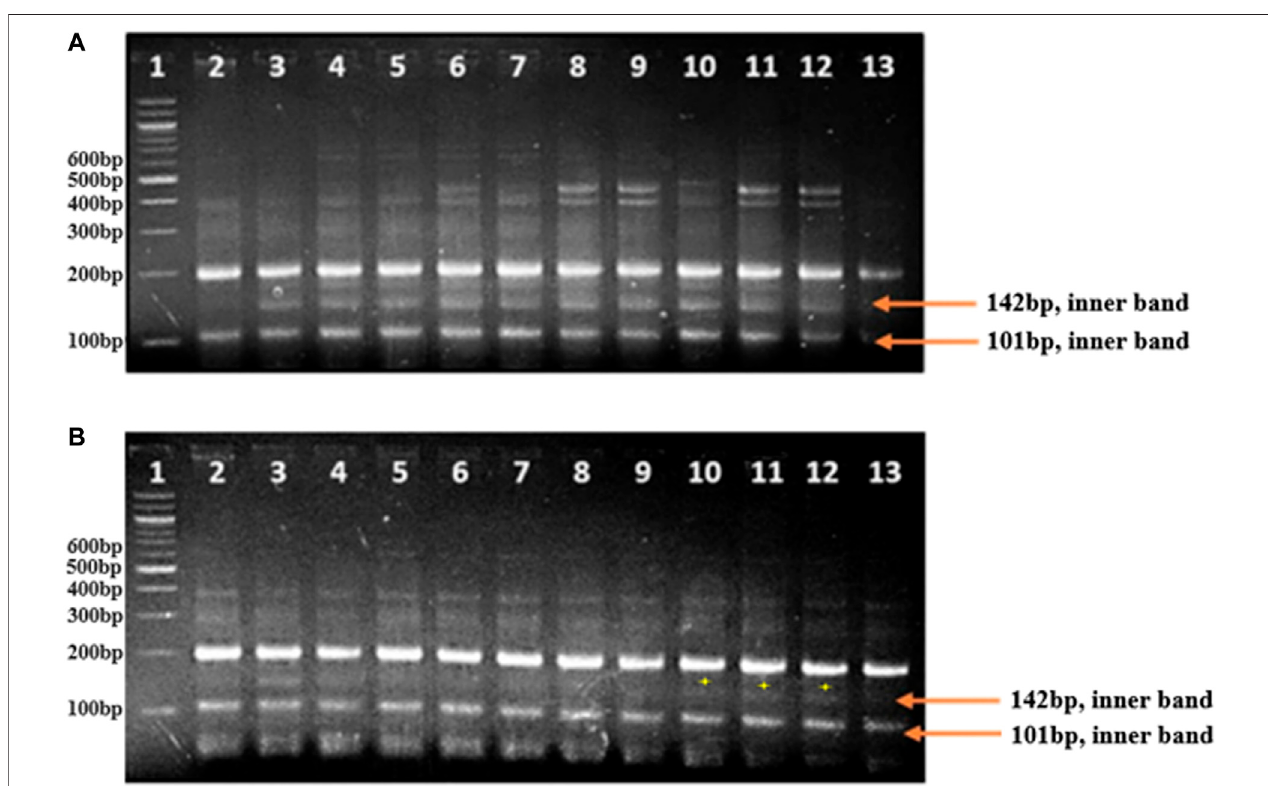
FIGURE 6 | (A) Lane 1: 100 bp ladder, Lane 2: susceptible parent, Lane 3: resistant parent, Lane 4 – 13: resistant lines. The resistant lines amplify the inner allele- speci fi c primer region with a product size of 142 bp, which is absent in the susceptible parent. (B) Lane 1: 100bp ladder, Lane 2: susceptible parent, Lane 3: resistant parent, Lane 4 – 13: susceptible lines. The inner allele-speci fi c primer region ampli fi es in the resistant parent at 142 bp and is absent in the susceptible lines except for lanes 10 –